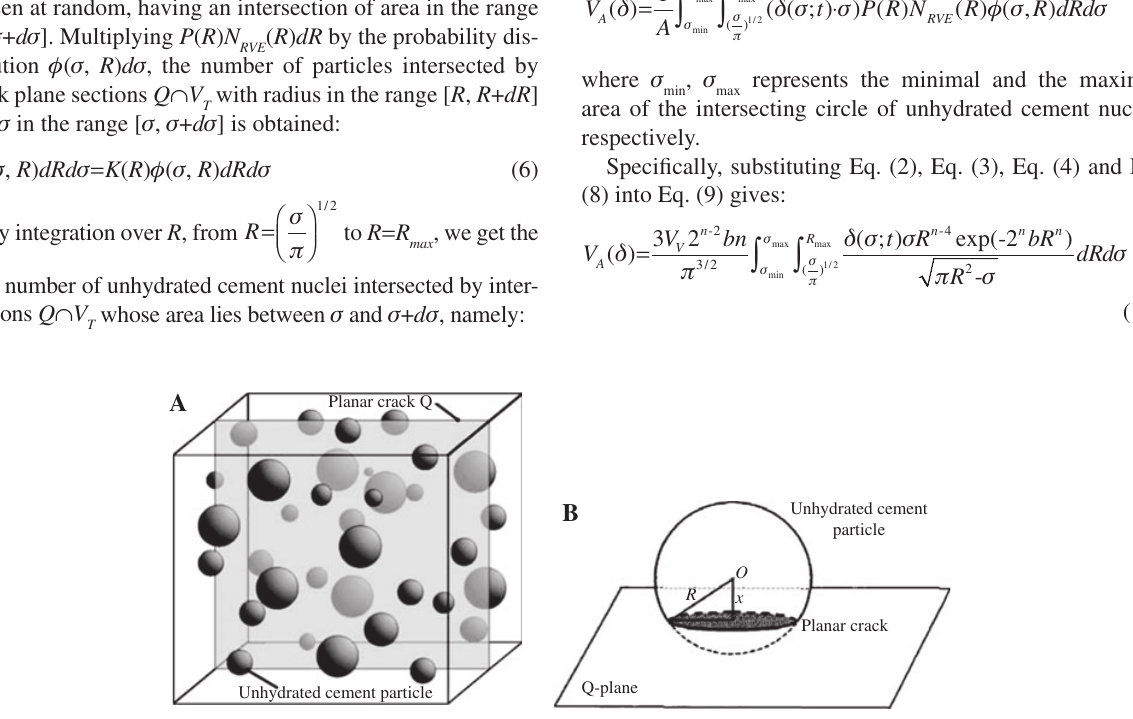
Figure 3 Splitting crack mode: (A) unhydrated cement nuclei intersected by crack plane; (B) single unhydrated cement particle split by the crack plane will continue to hydrate at its crack